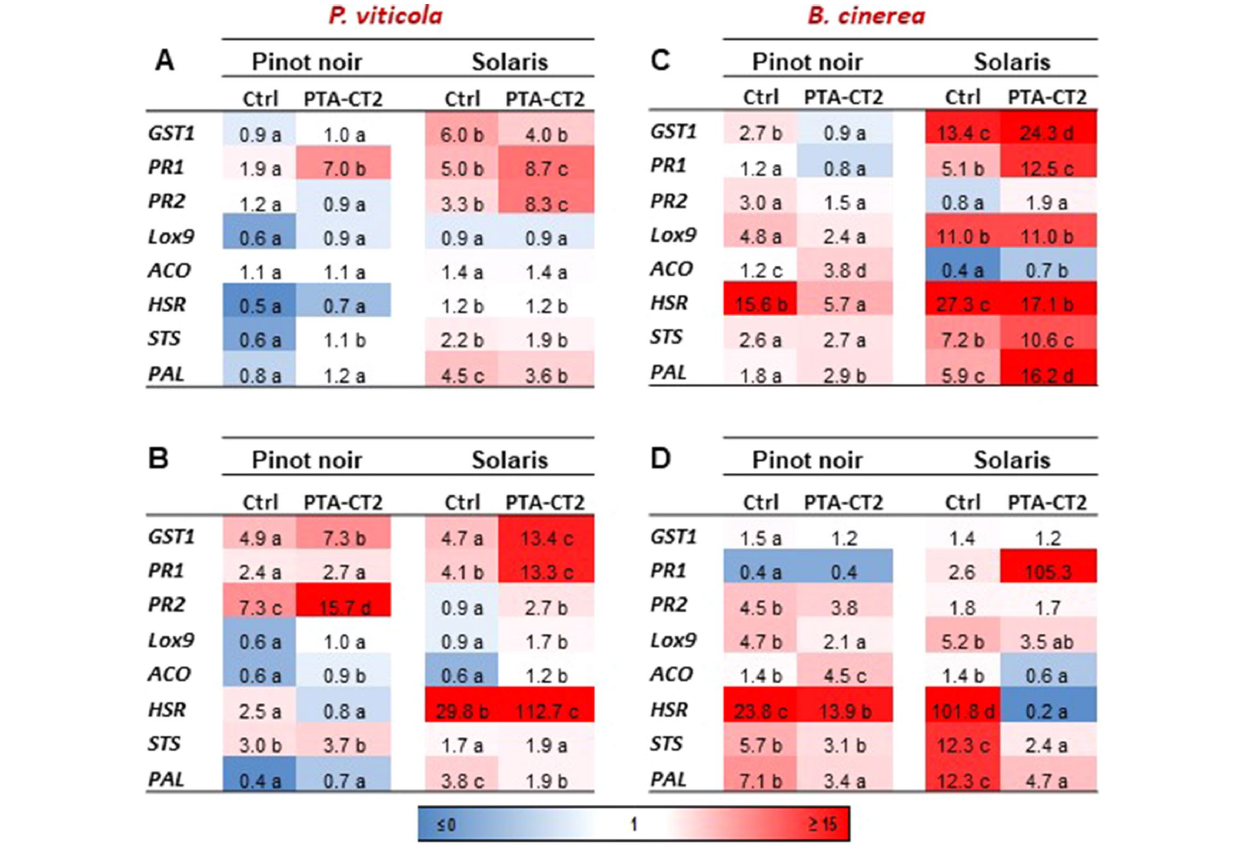
FIGURE 6 | Pseudomonas fluorescens PTA-CT2 primes differential expression of defense-related genes in leaf disks of Pinot noir and Solaris after Plasmopara viticola and Botrytis cinerea inoculation. Grafted plants were treated with P. fluorescens PTA-CT2 at the root level, and 2 weeks later, leaf disks were excised from control and treated plants and infected with 20 µl of 10 5 spores per milliliter of P. viticola (A , B) or 5 µl of 10 6 conidia per milliliter of B. cinerea (C , D) . The transcript level of defense-related genes was determined by quantitative reverse-transcription PCR (RT-qPCR) at 2 days post inoculation. Uninfected control of Pinot noir was considered as a reference sample (1× expression level) for both cultivars, and heatmaps represent changes in transcript expression levels as indicated by the color shading. Data are the means from three independent experiments performed in 2016 (A , C) and 2017 (B , D) . Different letters indicate statistically significant differences between the treatments (ANOVA Tukey test, P < 0.05). GST1 , glutathione-S-transferase 1; PR1 , pathogenesis-related protein 1; PR2 , β -1,3- glucanase; LOX9 , lipoxygenase 9; ACO , 1-aminocyclopropane-1-carboxylic acid oxidase; HSR , hypersensitive related; PAL , phenylalanine ammonia-lyase; STS , stilbene